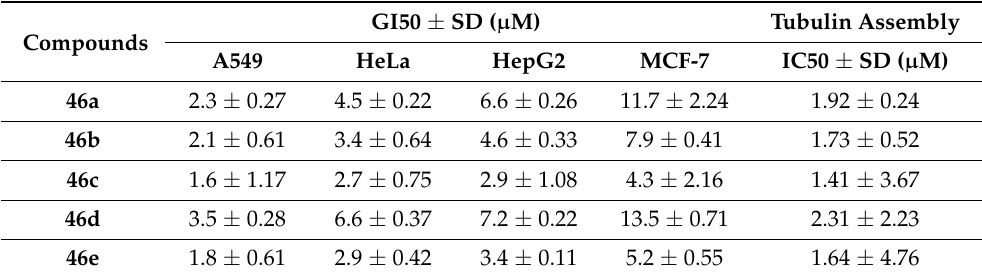
Table 1. Antiproliferative and anti-tubulin inhibition values of compounds 21a – e , combretastatin A-4, and